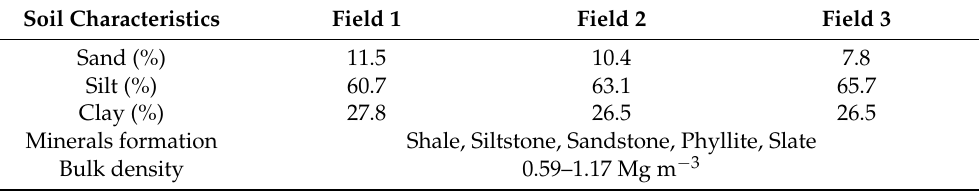
Table 2. Soil characteristics in the study